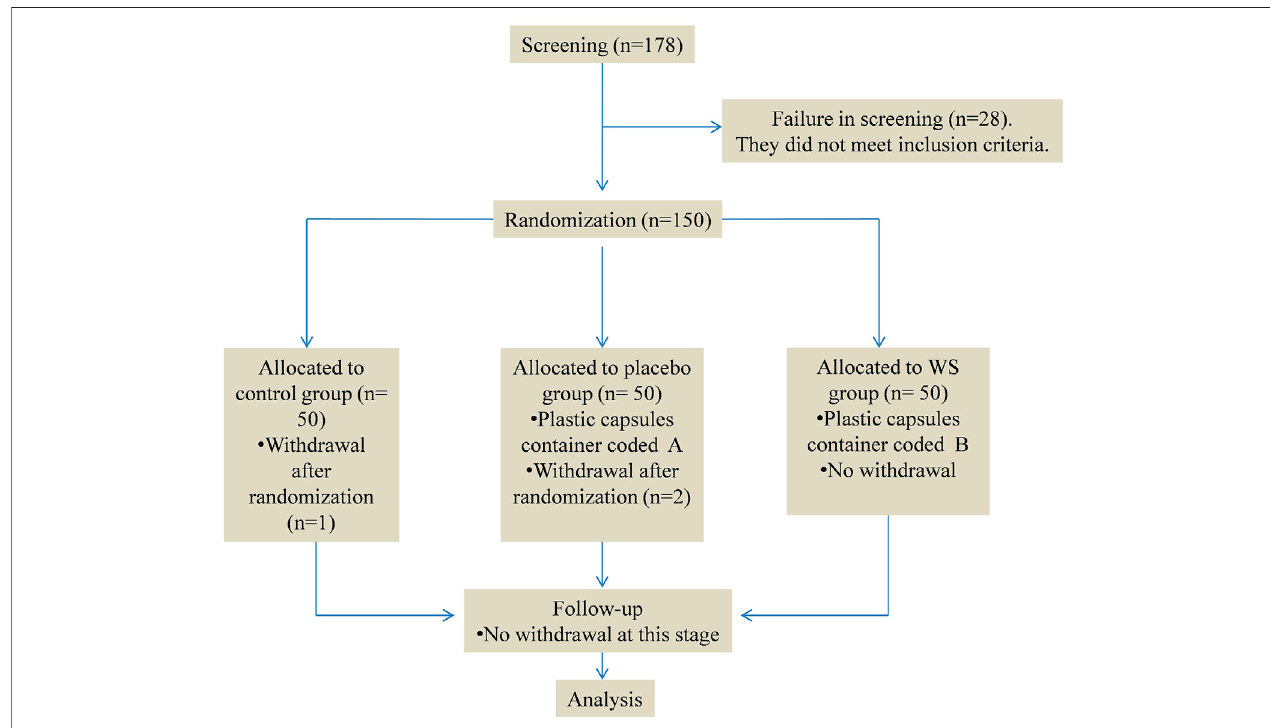
FIGURE 1 | Study fl